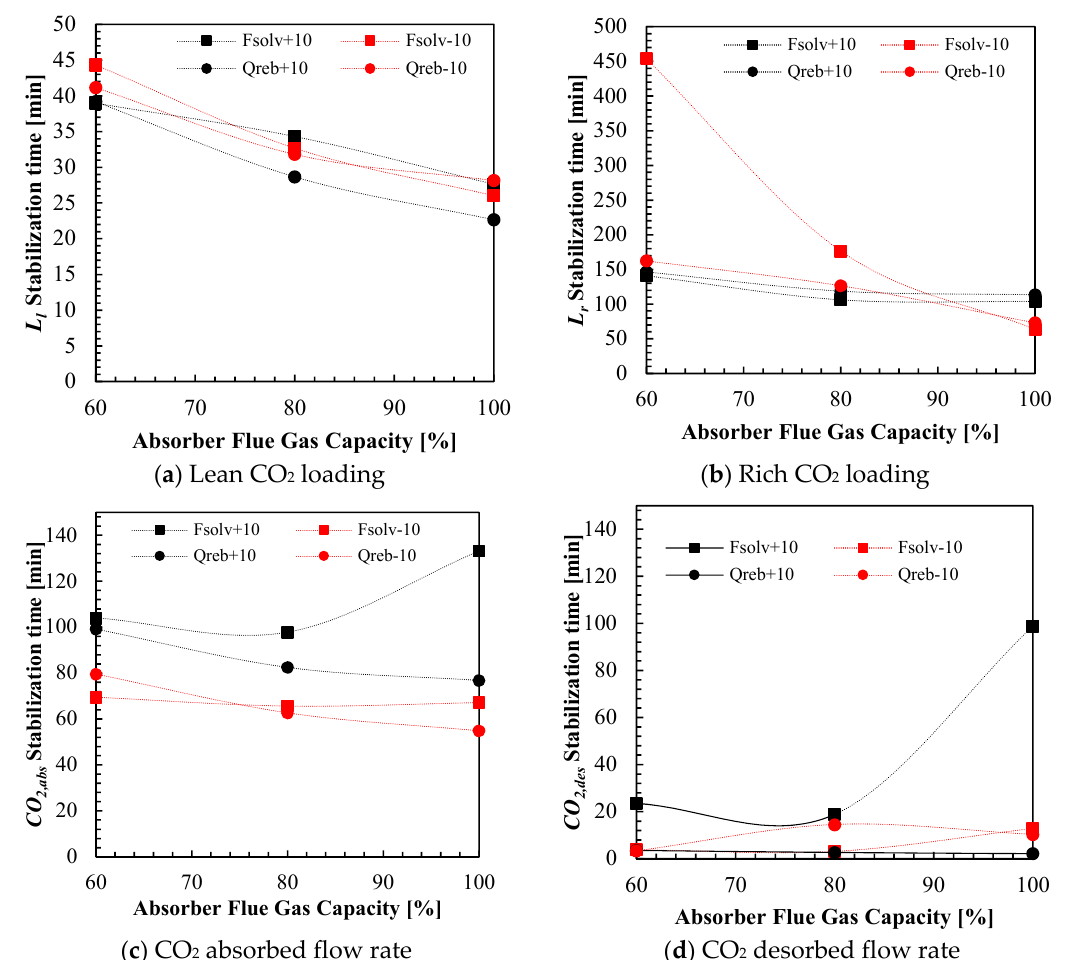
Figure 8. Simulation results. Total stabilization times t s for open-loop ± 10% step changes in solvent flow rate and reboiler duty for the process variables ( a ) Lean CO 2 loading L l ; ( b ) rich CO 2 loading L r ; ( c ) CO 2 absorbed CO 2,abs and ( d ) CO 2 desorbed CO 2,des . Stabilization times are calculated for the response when the plant is operated at three different operating points in terms of flue gas mass flow